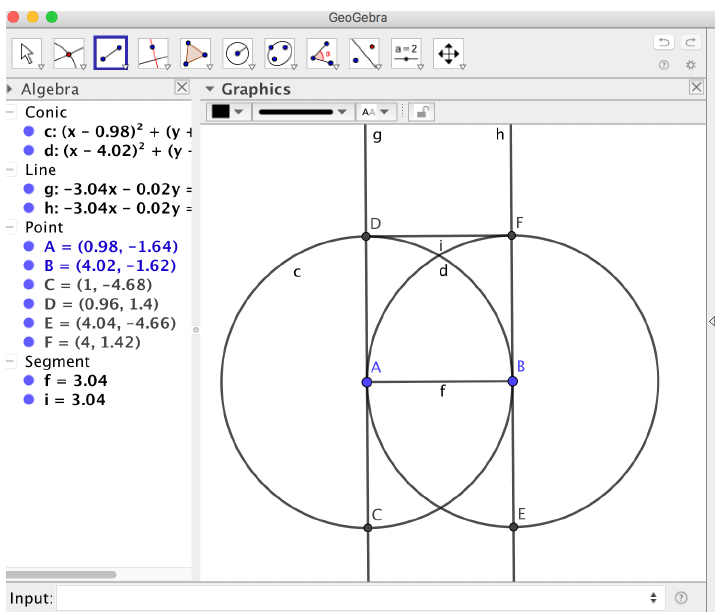
Figure 8. Construction associated to Example